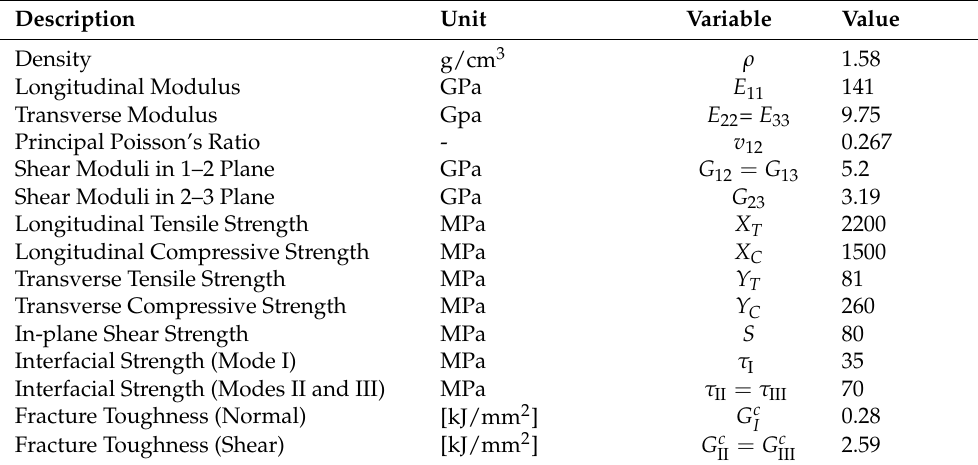
Table 1. The material properties of AS4/8552 composite